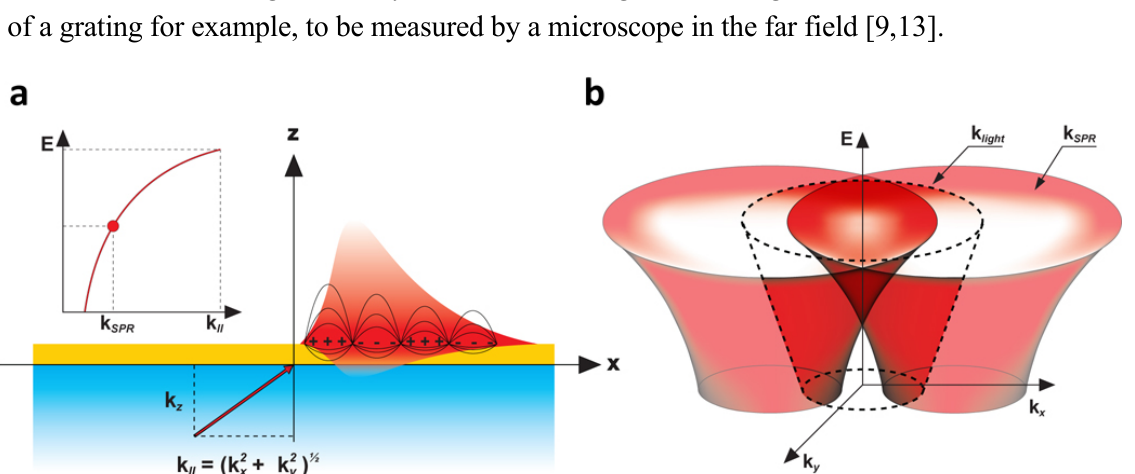
) SPR can take any ll , k ) space generates a cone-like x y > k . This SPR dispersion is thus SPR light